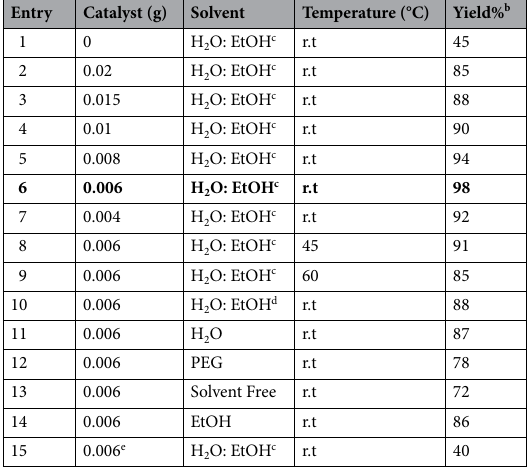
Table 9. Optimization of reaction condition for synthesis of 1,4-dihydropyrano[2,3-c]pyrazole a . a 4-Chlorobenzaldehyde (1 mmol), malononitrile (1 mmol), ethyl acetoacetate (1 mmol), hydrazine hydrate (1 mmol), 20 min. b Pure yield. c Ratio: 2:1 mL. d Ratio: 1:1 mL. e Reaction catalysed by HMS/Pr-PTSC.